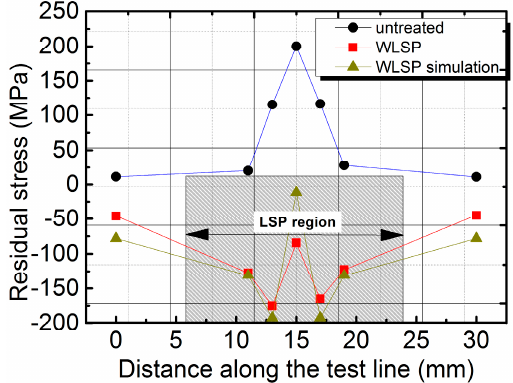
Figure8. Surface residual stress distributions of specimens. Figure 8. Surface residual stress distributions of